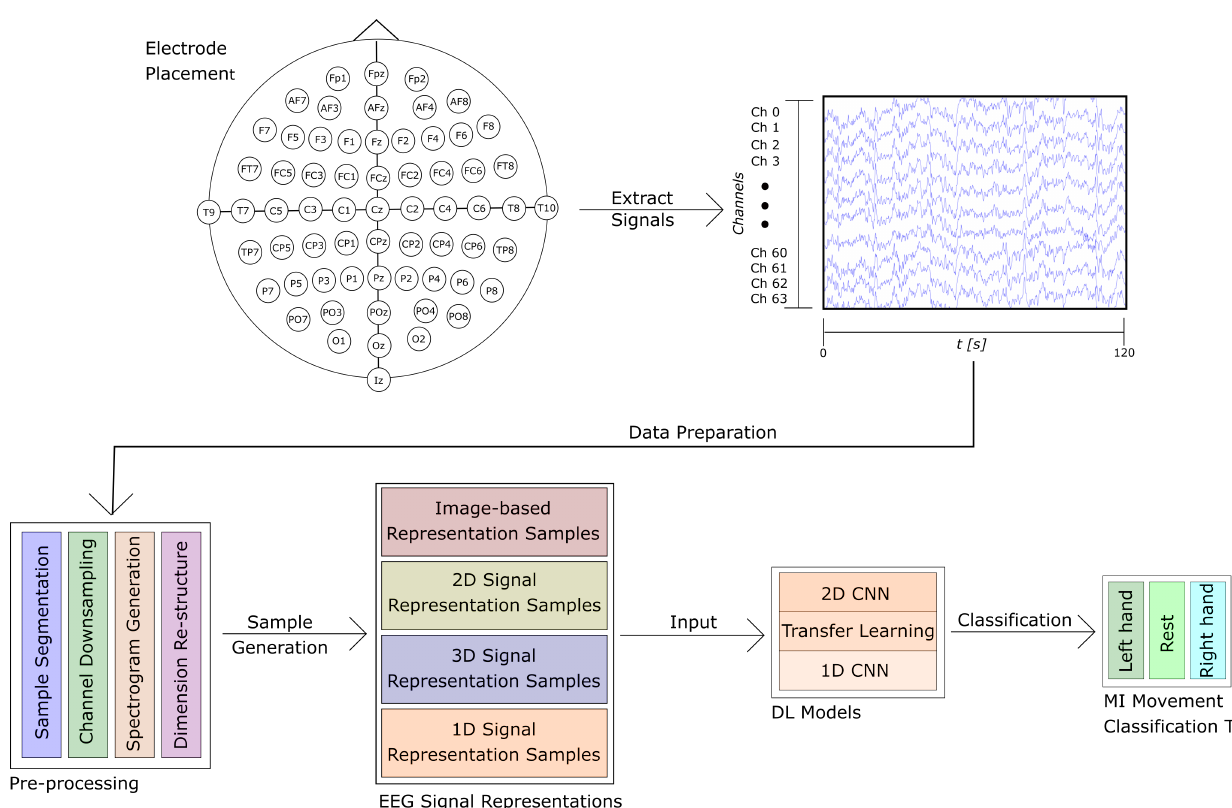
Figure 3. Once the signals are acquired, the recordings are segmented into four-second intervals to generate the samples for each class. Samples are prepared as described in Sections 2.2 and 2.3, with signal transformation to spectrogram images, data dimension re-structuring, and channel downsampling. Finally, the samples are used as input for the proposed models described in Sections 2.4 and 2.5 for the 3-class classification of MI for rest, left-, and right-hand movement. Table 1. Contents of each recording from Physionet’s EEG Motor Movement/Imagery Dataset [27]. Baseline recording with open eyes